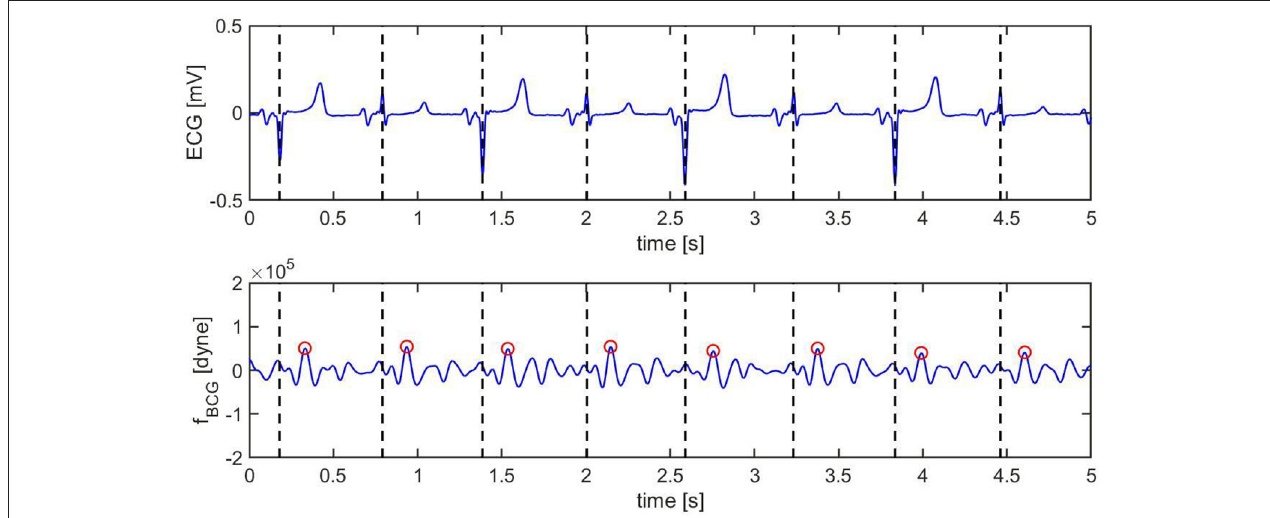
FIGURE 10 | Comparison between BCG waveforms measure before (blue) and after (red) myocardial infarction on a swine. The curves have been aligned with respect to the preceding R peaks in the ECG (vertical dashed line).